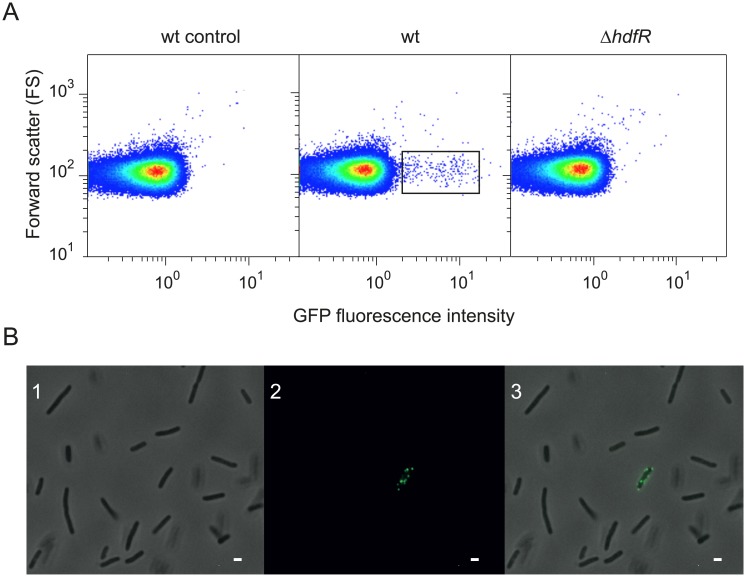
Bistable expression of the std operon.A. Single cell analysis of GFP fluorescence intensity by flow cytometry in a strain carrying an stdA::gfp fusion in different genetic backgrounds (wt and ΔhdfR). On the left, a negative control is shown (S. enterica cells without gfp fusion). B. Detection of Std fimbriae by immunofluorescence microscopy. Panel 1 shows a phase-contrast image of S. enterica cells. Panel 2 shows detection of Std fimbriae with anti-StdA antiserum and goat anti-rabbit antibody conjugated to FITC (green signal). In panel 3, both channels are merged. Scale bar: 1 μm.